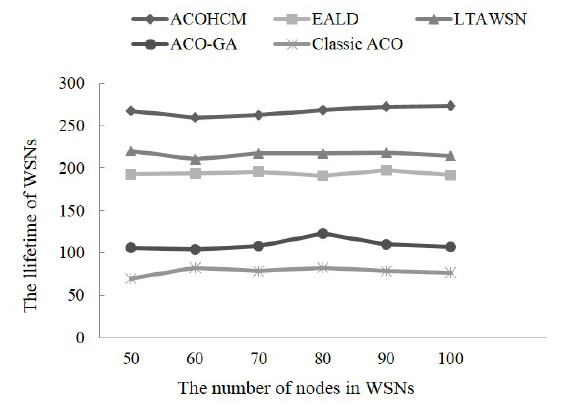
Figure 3. The network lifetime of the different algorithms changing with the number of